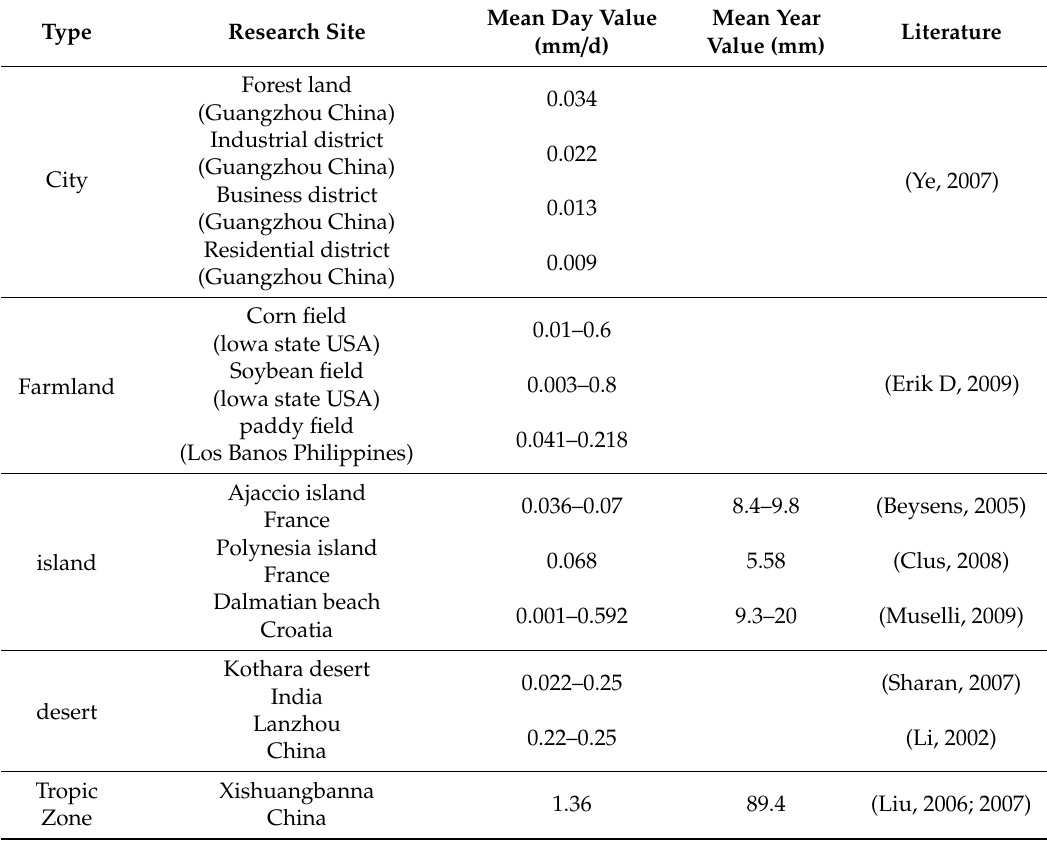
Table 1. Horizontal precipitation in di ff erent